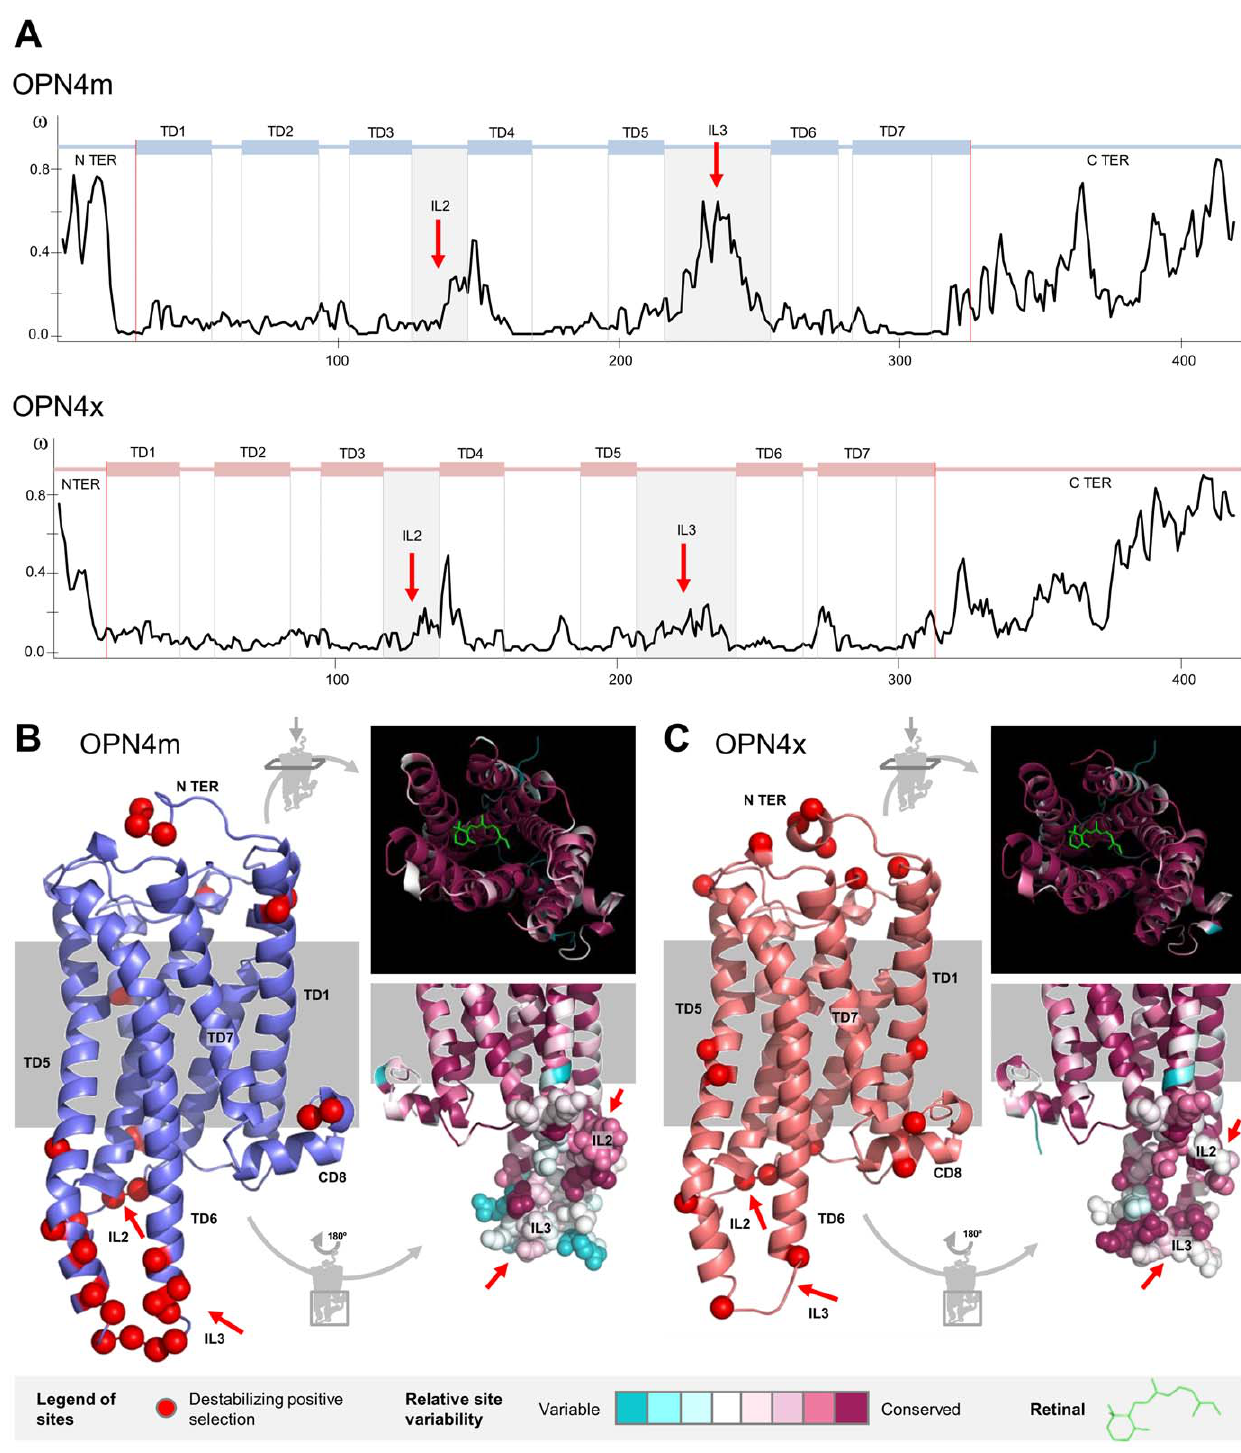
Figure 3. Destabilizing positively selected sites and conservation index in the OPN4m and OPN4x paralogs. A. v -ratio site estimation for each melanopsin paralog. The IL2 and IL3 regions are highlighted (red arrows). B and C. Three-dimensional structure of OPN4m and OPN4x paralogs showing the sites under positive destabilizing selection (red) and detailed perspectives of the conservation index in the interior of the molecule, where the retinal is accommodated, and the IL2 and IL3 loops (red arrows). doi:10.1371/journal.pone.0052413.g003 parameters and the inferred selected amino acid sites are identification of sites are based on the Gallus gallus OPN4m and presented in table S3 . All the numerical and amino acid OPN4x protein sequences.